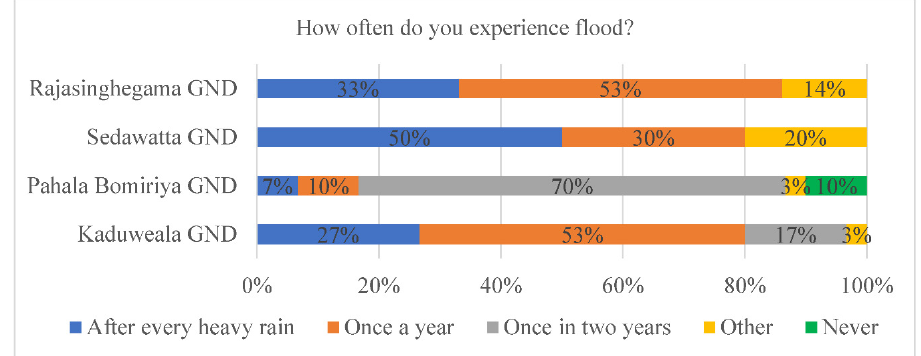
Figure 3. How often respondents experience